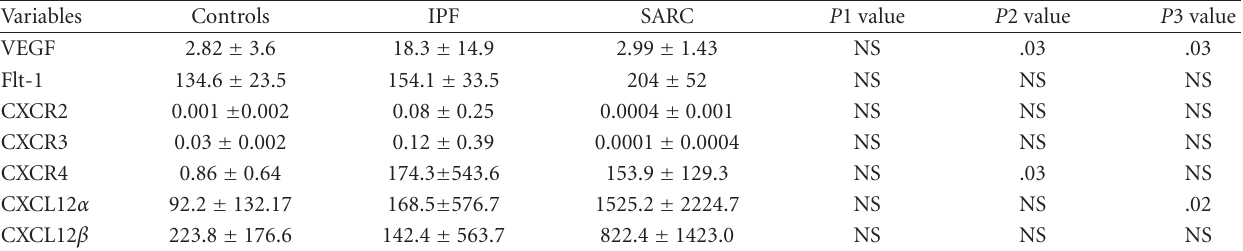
Table 4: mRNA expression of VEGF, FLT-1 and angiogenetic chemokines in healthy subjects (Controls), Sarcoidosis (SARC) and IPF patients. Values are expressed as mean ±